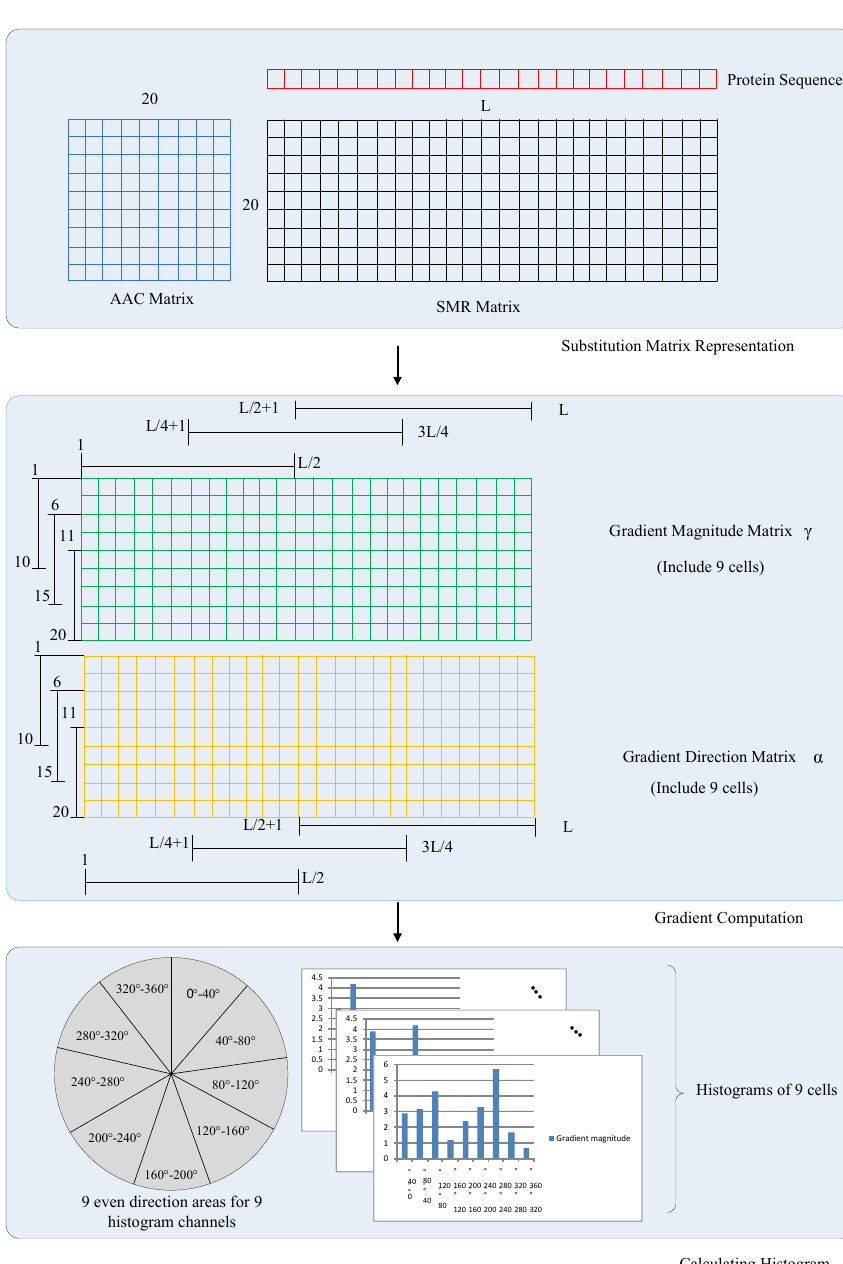
Figure 2. The schematic diagram for calculating Histogram of Oriented Gradient